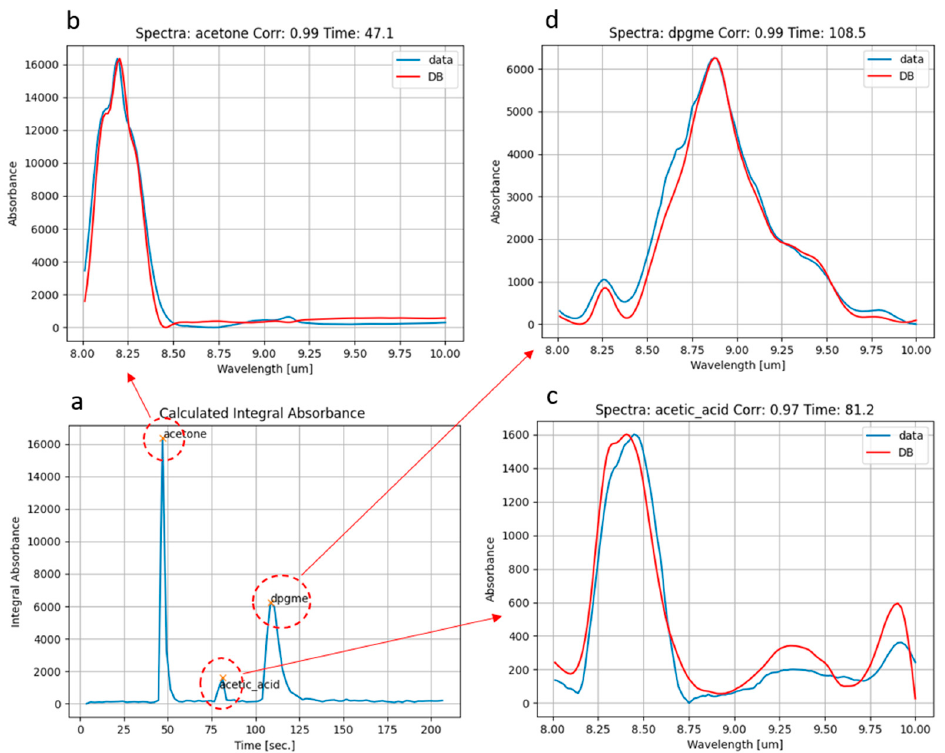
Figure 6. Total absorption chromatogram ( a ) obtained for a sampled mix of acetone and DPGME; spectra measured (blue line) and corresponding best fit from database (red line) of acetone ( b ) and DPGME ( d ) at the corresponding peaks of integral absorbance. A third intermediate peak was observed, whose corresponding measured and best-fit database spectra ( c ) correspond to acetic acid.